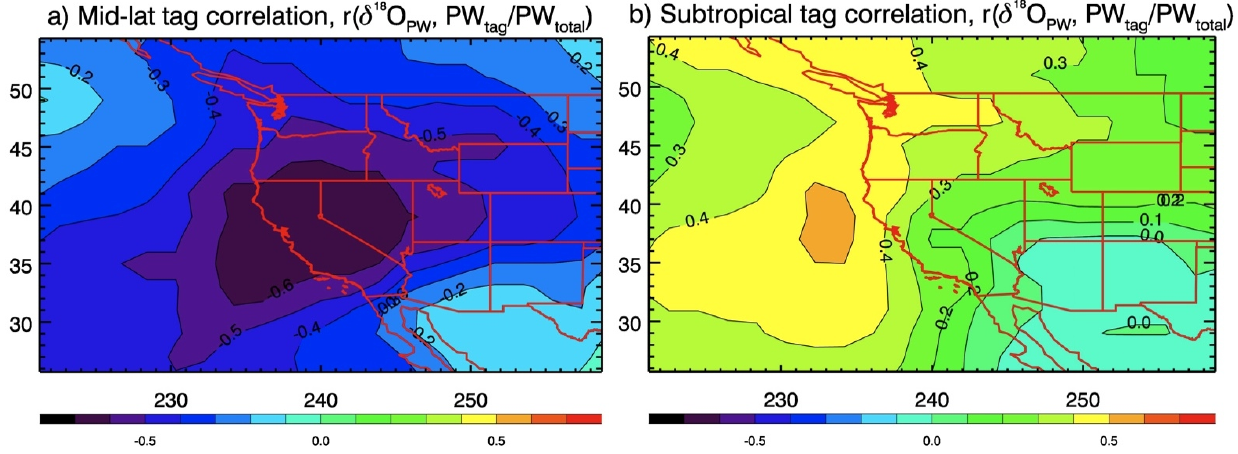
Figure 11. ( a ) Correlation between interannual δ 18 O precipitable water from middle latitude tags; and ( b ) subtropical tags. Contour intervals are 0.1. Absolute values of r above 0.263 are significant above the 95% confidence